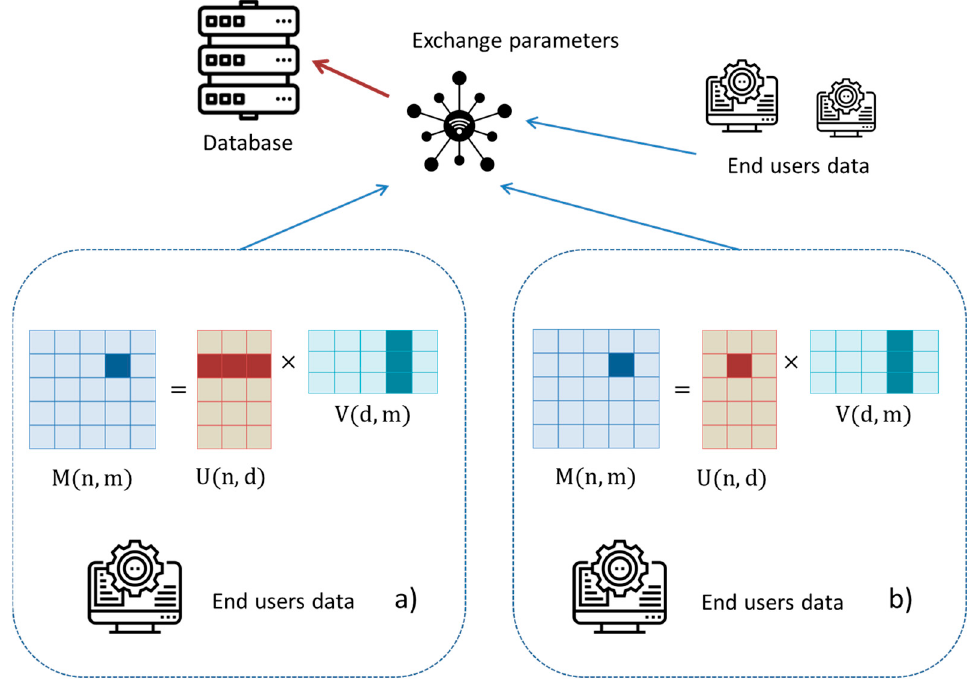
Figure 10. Recommendation system using Funk SVD ( a ) and modified Funk SVD ( b ) algorithms.